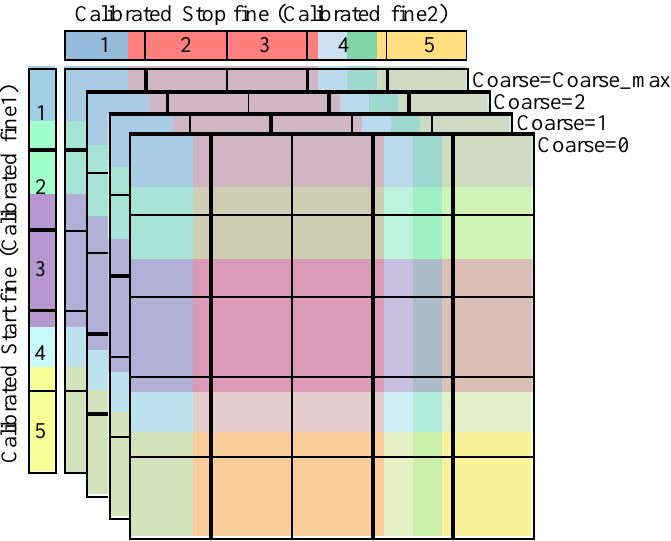
Figure 10. Column calibration, the individual calibration of the columns using the average-bin- width method gives a semi-calibrated histogram where all the rows have the same height. 3. Step 3: Row calibration.